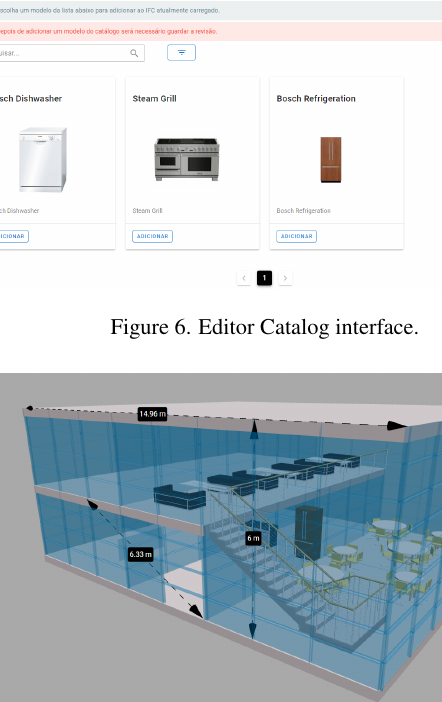
Figure 3. Viewer- IFC 3D rendering.